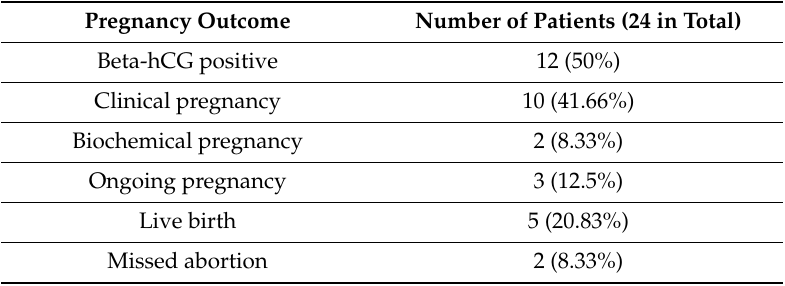
Table 2. Pregnancy outcome in 24 patients who underwent frozen embryo transfer after platelet-rich plasma (PRP)